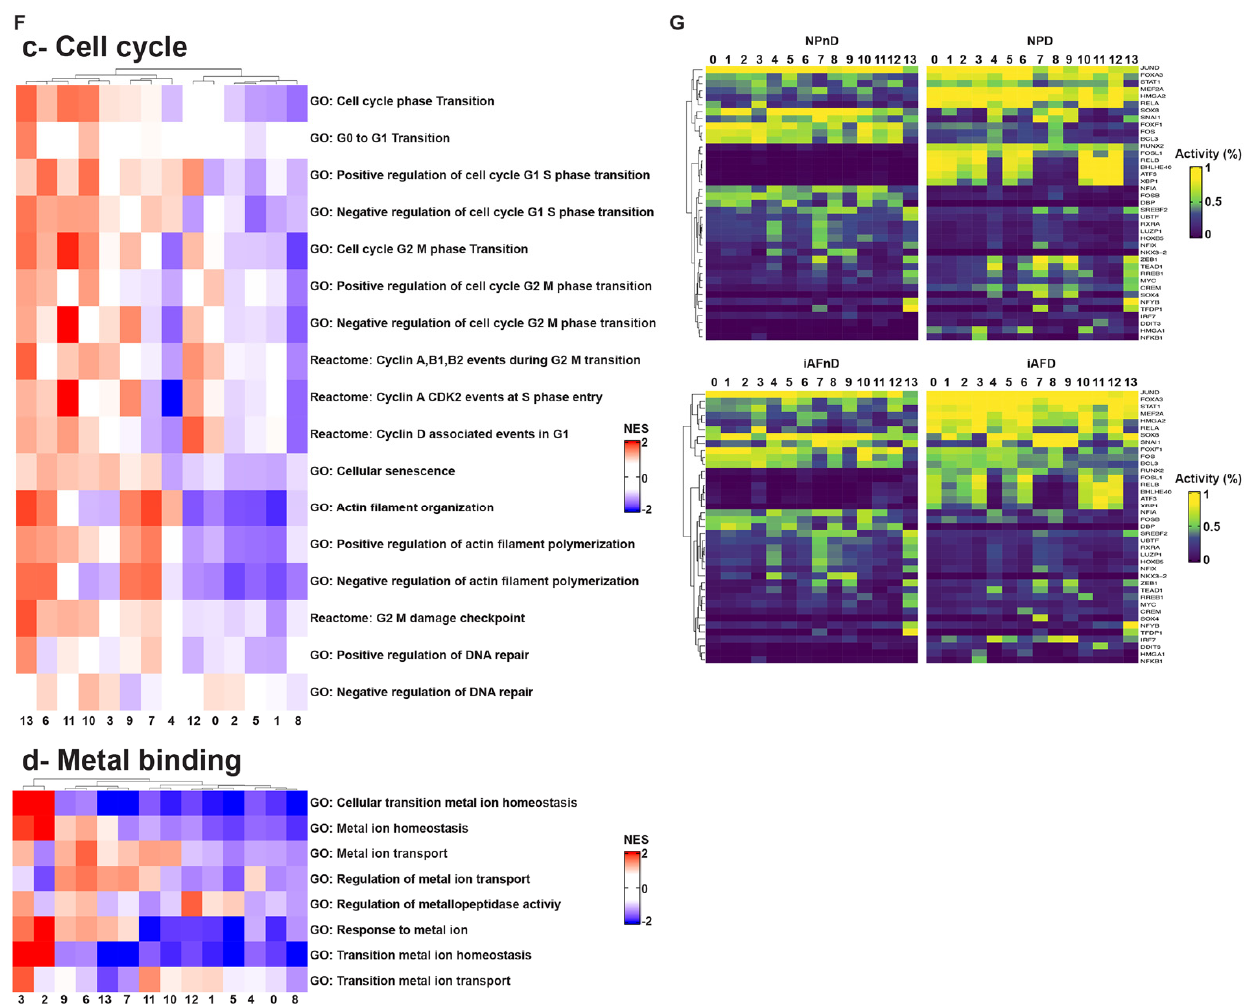
Figure 2. Single-cell RNA profiling and transcriptional changes correlated with cell type and IVD degeneration. Unsupervised UMAP clustering showing the change in cell distribution of the 14 different clusters for ( A ) NPnD, ( B ) NPD, ( C ) iAFnD and ( D ) iAFD. ( E ) Variations in cell proportion of the 14 different clusters between the samples. ( F ) QuSAGE analysis of cell population specific differential expression colored by statistically significant normalized enrichment scores. The main discovered IVD cell functions were presented in heatmaps in ( a ) matrix regulation, ( b ) response to stress and inflammation, ( c ) cell cycle and ( d ) metal binding. ( G ) Heatmap showing grade-related TFs in the identified 14 cell clusters.